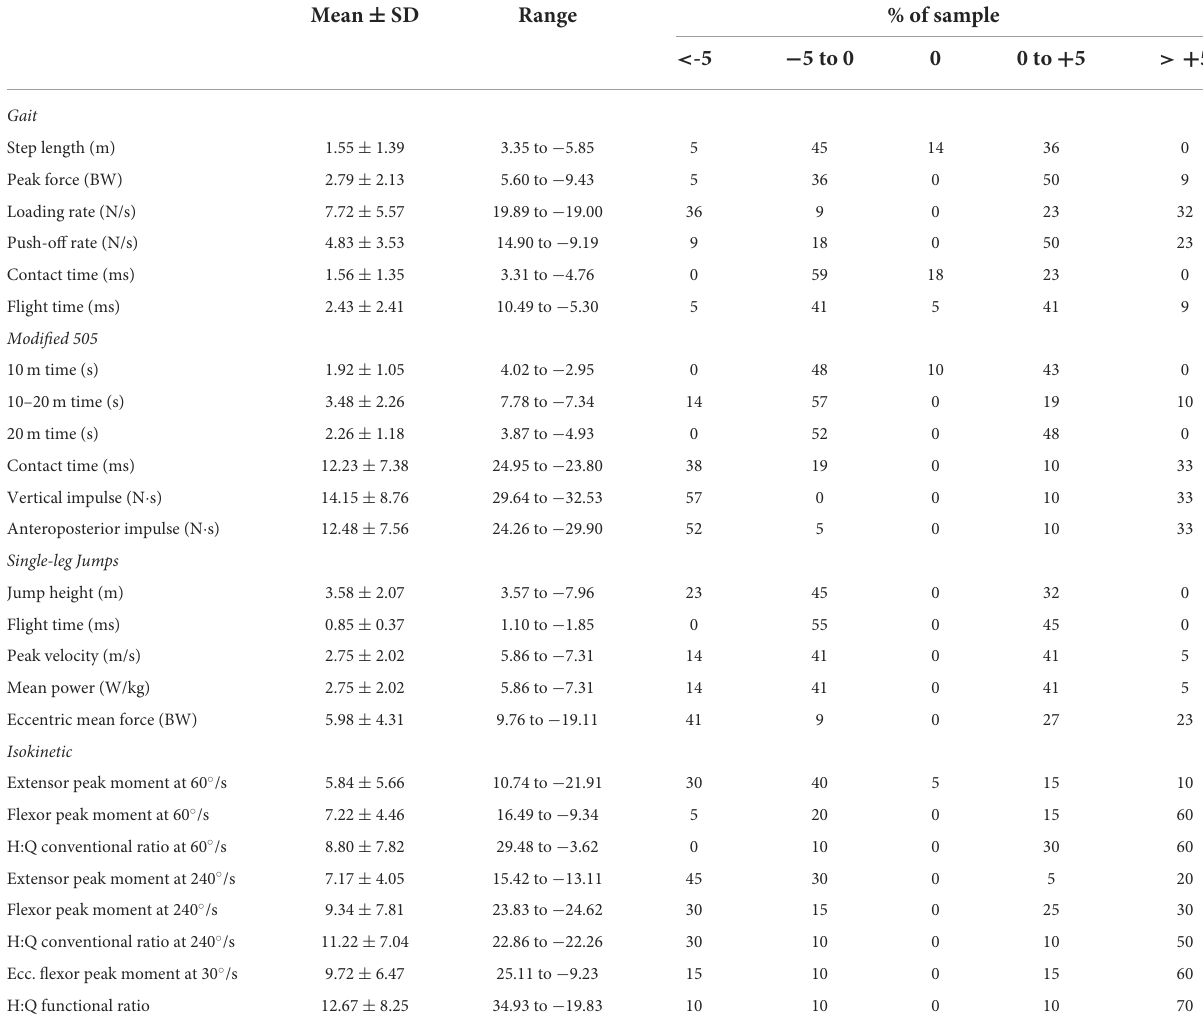
TABLE 2 Mean ( ± SD) and range of asymmetry values for all variables.